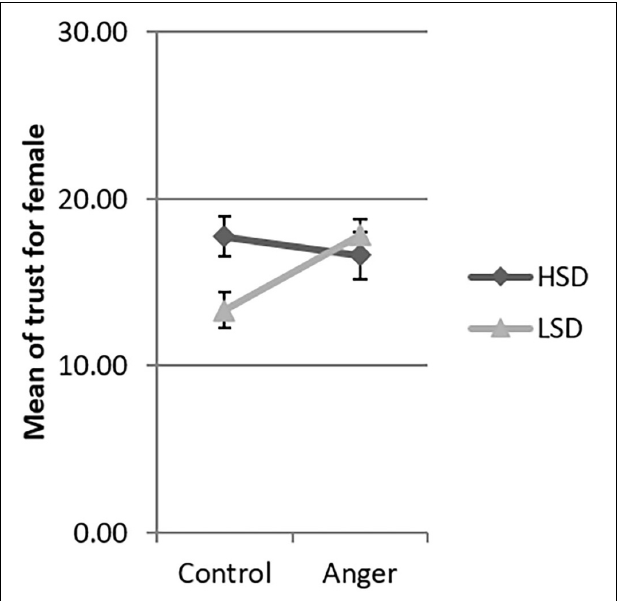
FIGURE 5 | Mean of trust of female across the four experimental conditions in Study 2. LSD, low social distance; HSD, high social distance. Error bar is the standard